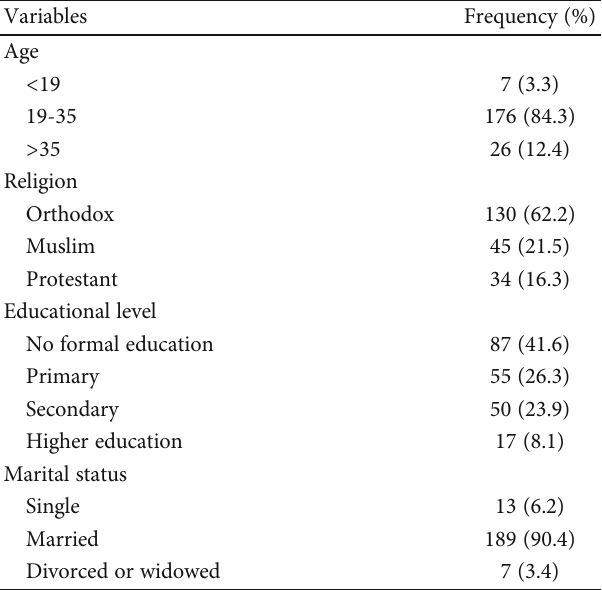
Table 1: Characteristics of women in SPHMMC ’ s labor ward, Addis Ababa, Ethiopia,